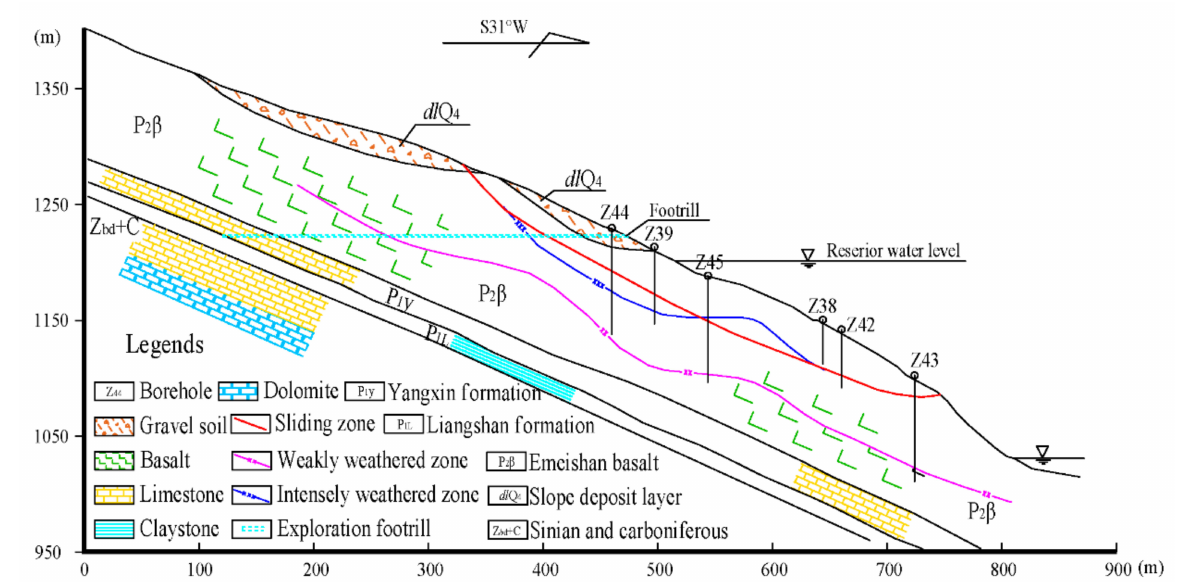
Figure 2. Geological section of the landslide (modified from Cheng and Li 1991; Li